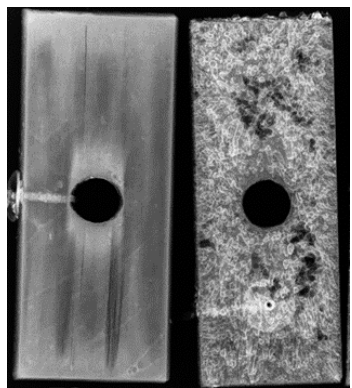
Figure 2. Wood borer attack on SCA-treated ( left ) and untreated control Scots pine sapwood ( right ) after four months exposure in the Oslofjord. Table 4. Attack rating after 4 months of wood borer attack (shipworm) in treated and untreated control wood species in Drøbak and Moss